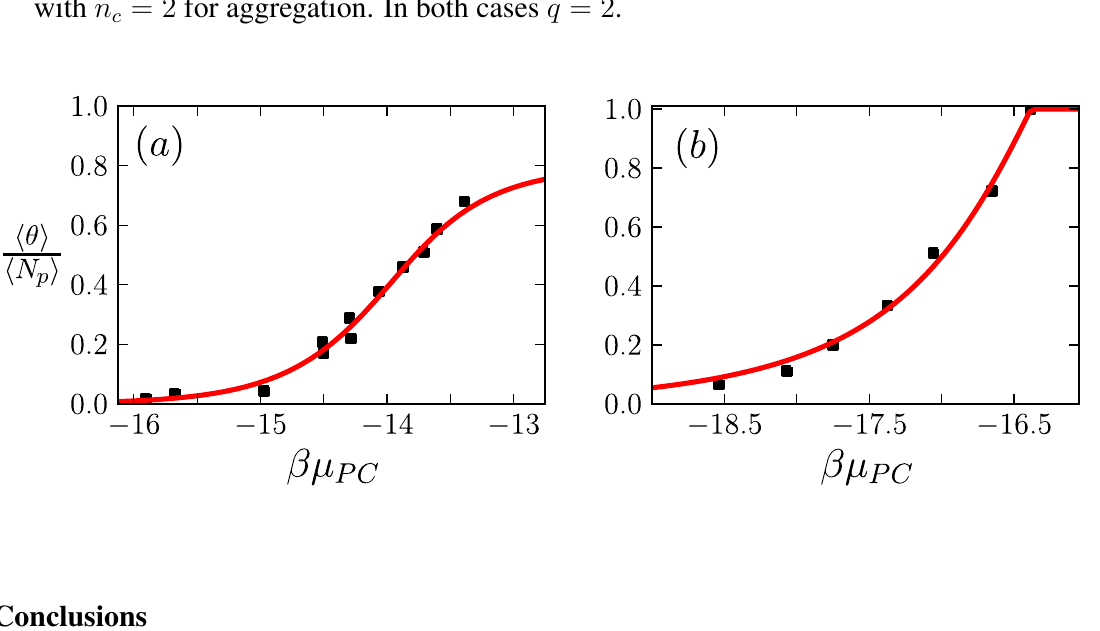
(cid:105) is fitted to the results of the Terzi et al. experiment [52] involving Figure 12. ( a ) (cid:104) θ (cid:105) / (cid:104) N p Aβ (1-40) aggregates; ( b ) The fraction of sheet proteins in Curli fibrils is fitted to the scaled results of the Hammer et al. experiment [84]. In ( a ), the fit parameters were P ≈ K ≈ A ≈ 0 kcal/mol, R = 0 . 35 kcal/mol, and F = 16 . 4 kcal/mol.; while in ( b ) we 1 1 = 7 . 26 kcal/mol, K = 2 . 2 kcal/mol, R ≈ 0 kcal/mol, and A = 1 . 2 kcal/mol [26]. have P 1 1 = 2 whereas in ( b ) we used the 1D model In ( a ) we used case B of the strip models with n c = 2 for aggregation. In both cases q = 2 with n c